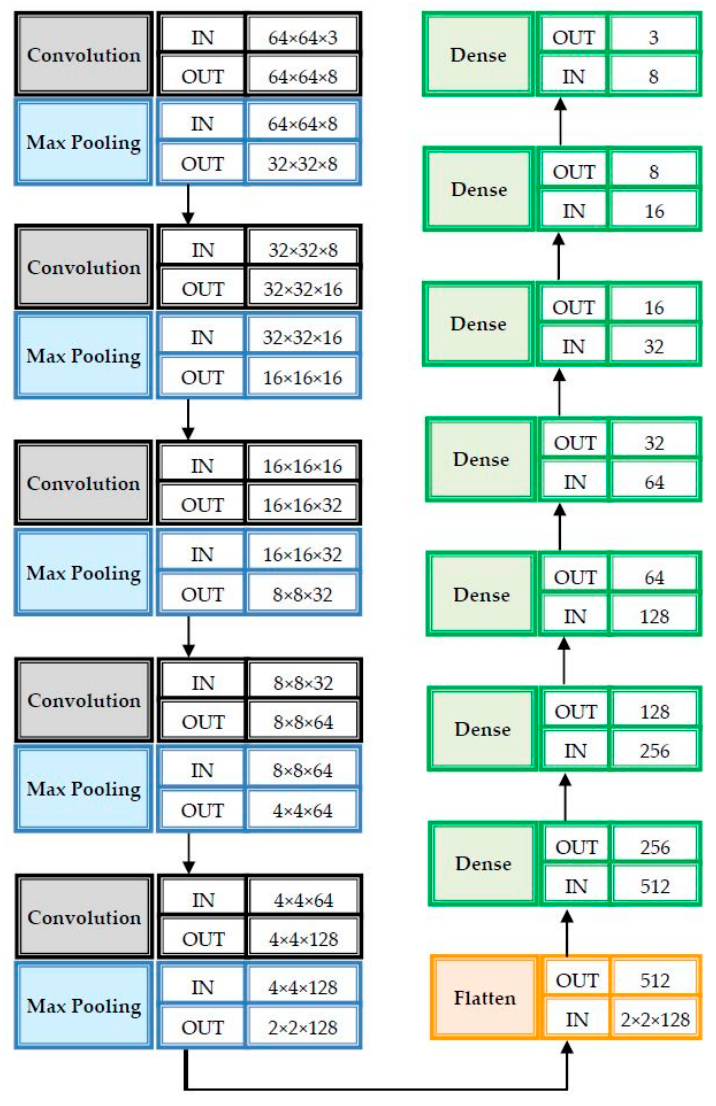
Figure 7. LeNet architecture.